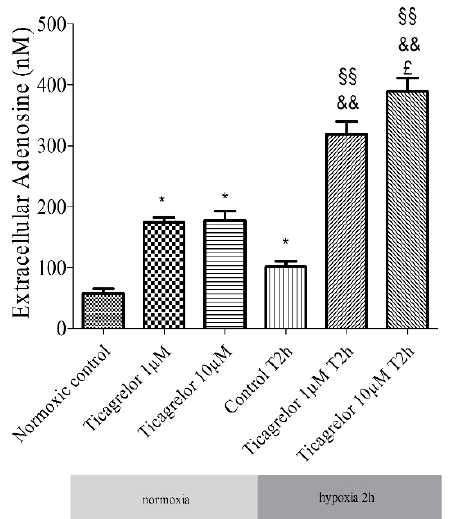
Figure 4. Extracellular adenosine concentration: effect of 1 µM and 10 µM ticagrelor after 2 h of hypoxia stress in HUVECs. Extracellular adenosine concentrations are expressed in nM. Results are expressed as means ± sem ( n = 6/group). *: p < 0.05, compared to the normoxic control group; §§: p < 0.01 compared to control T2h, &&: p < 0.01 compared to ticagrelor normoxia for each corresponding concentration, £: p < 0.05, compared to ticagrelor 1 µM T2h group.